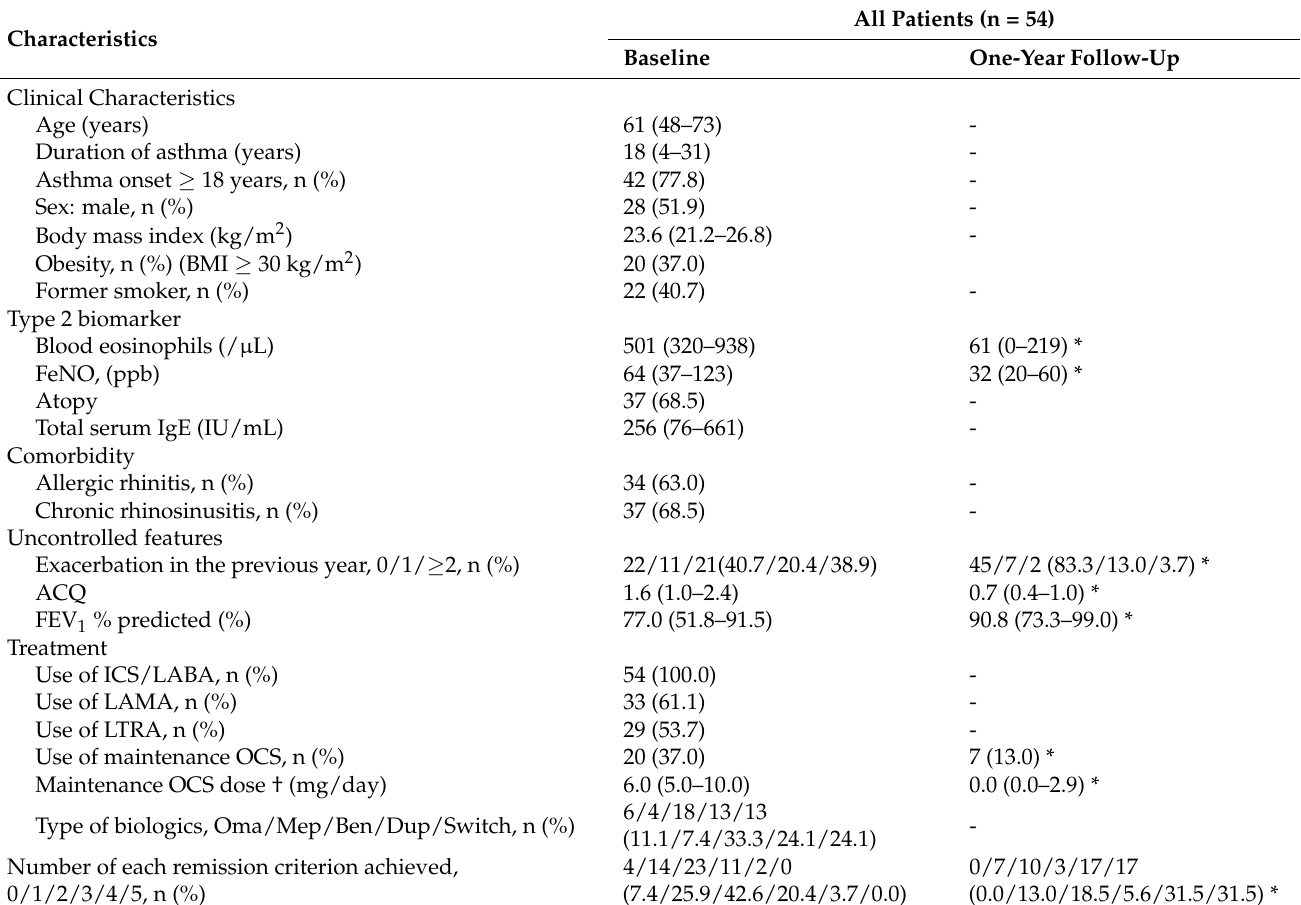
Table 1. Patient characteristics at baseline and 1-year